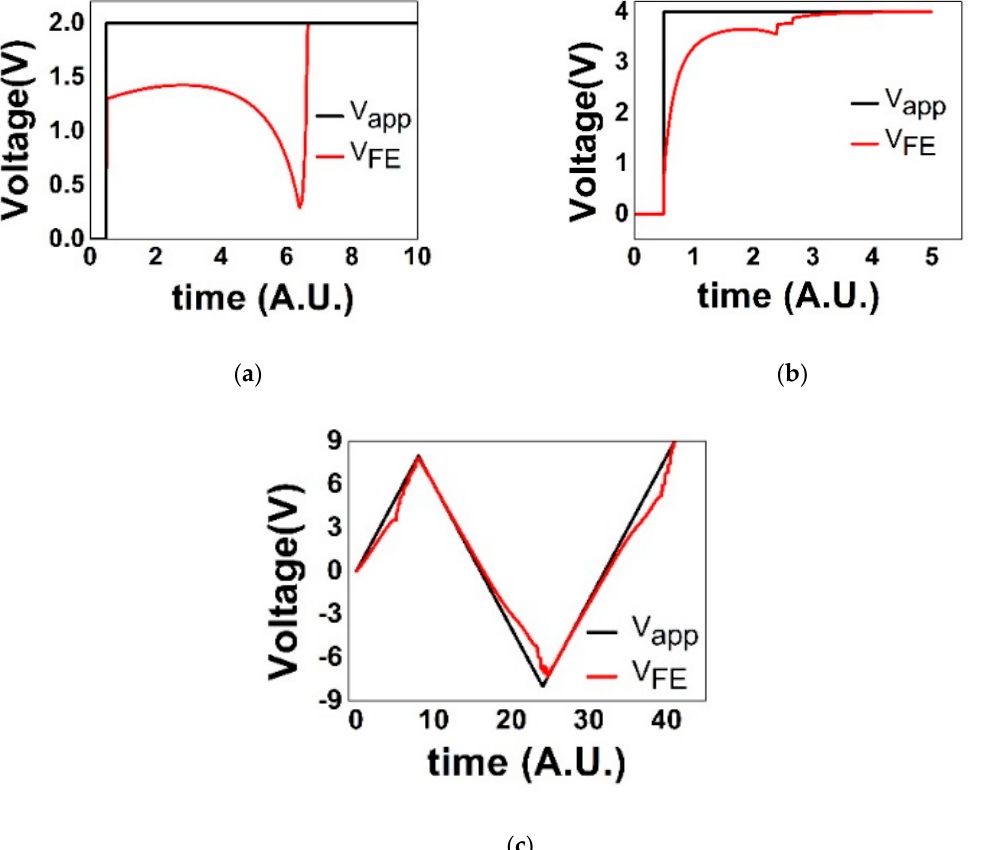
Figure 6. Simulated transient negative capacitance (NC) of the R-FEC circuit with different dimensions (2D or 3D) and waveforms (square or triangular). The structure of the ferroelectric capacitor is metal-ferroelectric-metal (MFM): ( a ) 2D phase field simulation; ( b ), ( c ) 3D phase field simulation with different waveforms.